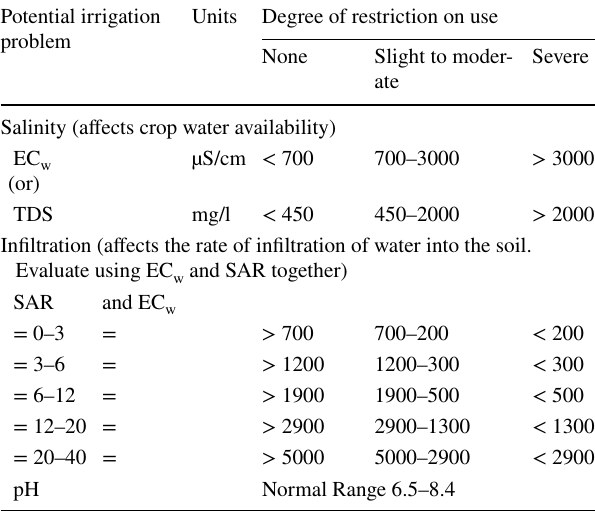
EC w electrical conductivity (of water), TDS total dissolved solids, SAR sodium